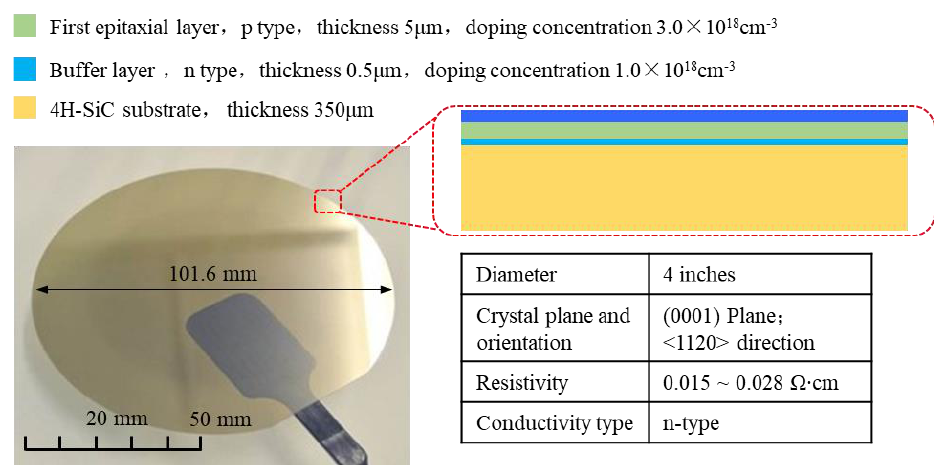
Figure 4. Structure and physical parameters of the 4H-SiC epitaxial wafer.